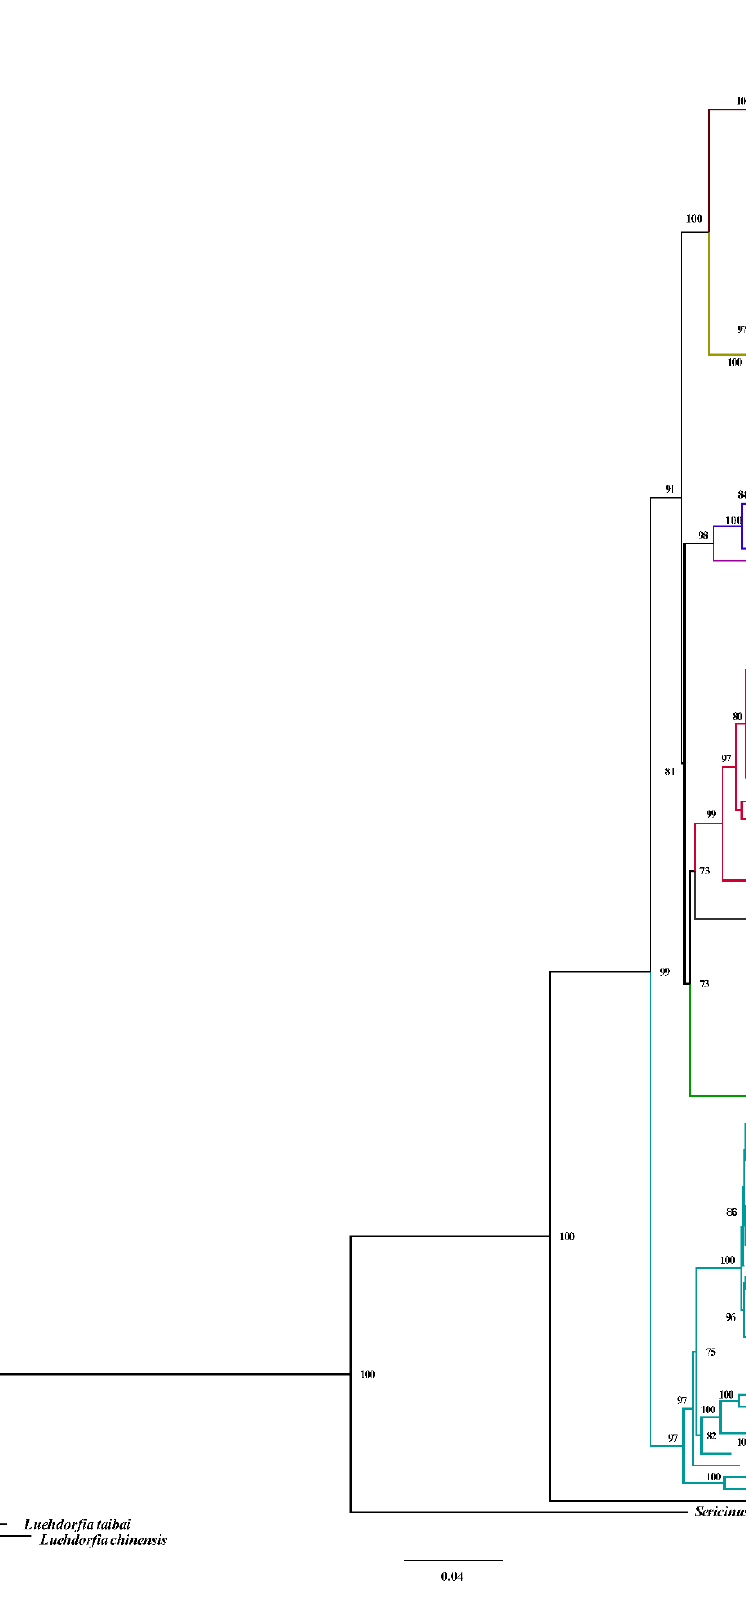
Figure 3. Maximum likelihood phylogenetic tree of 45 Parnassius species based on three mitochondrial gene sequences. The sequences are shown in File S1.